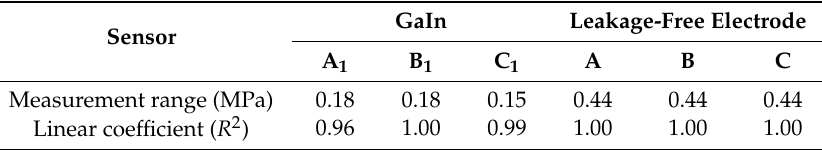
Figure 8. ( a – c ) Pressure response curves of the GaIn and the leakage-free electrode-based sensors. ( d ) Sensitivities of Sensor A, B, and C with different electrodes. Table 2. Comparison of the GaIn and the leakage-free electrode-based sensors.